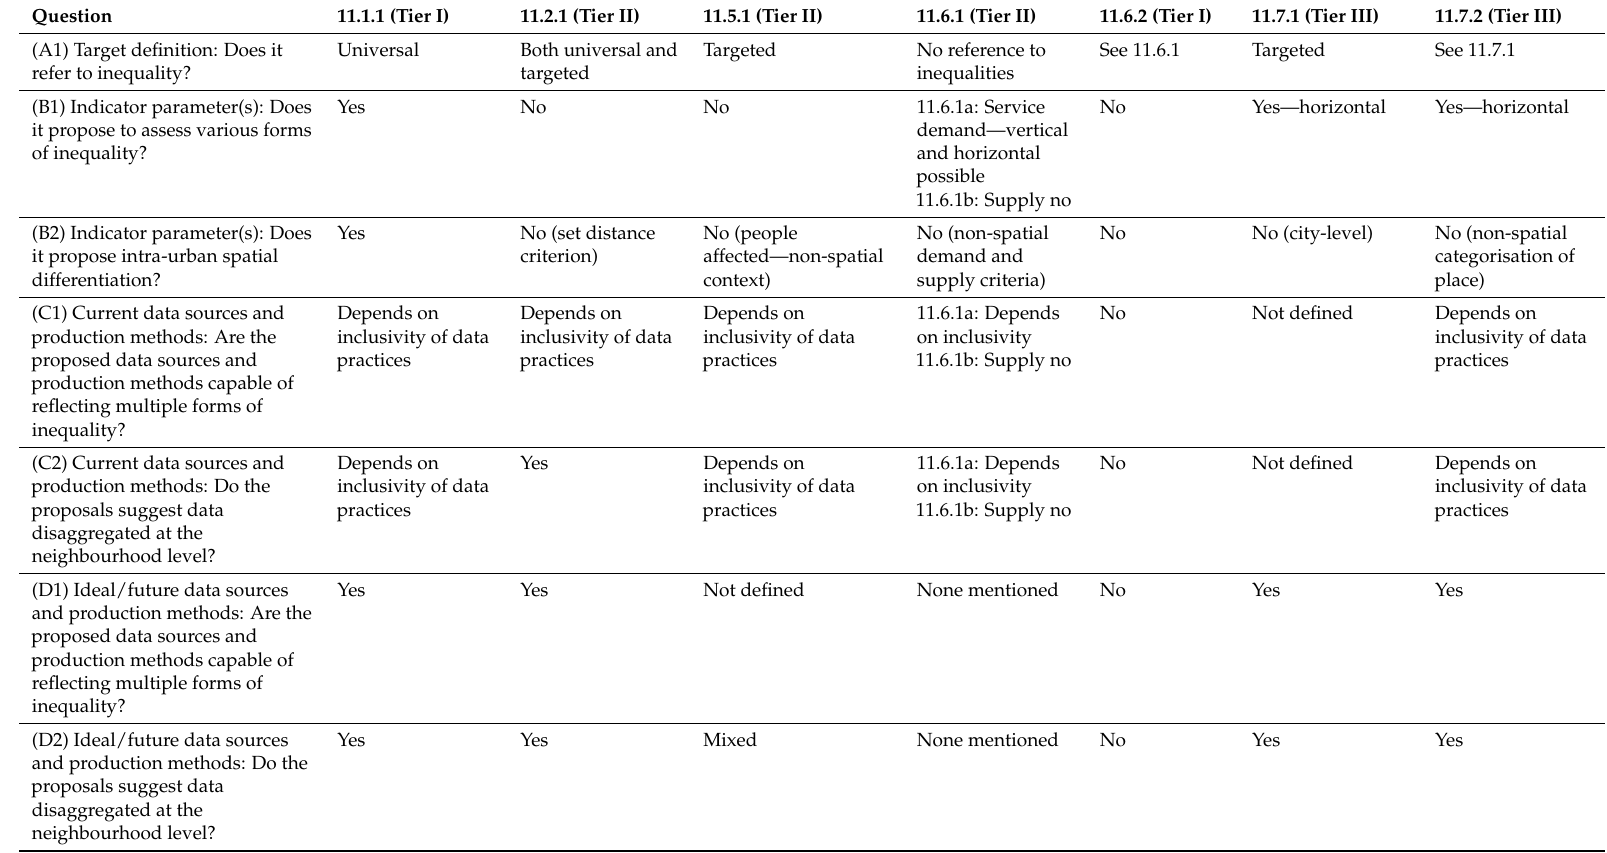
Table 3. Analysis summary